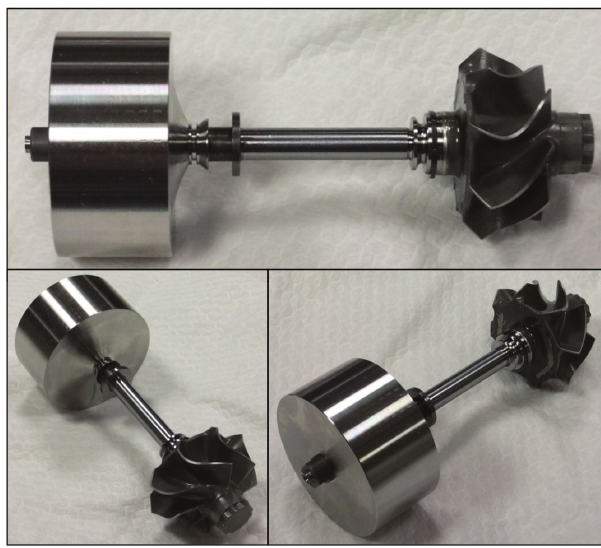
Figure 15: Typical result of an unsteady HIR measurement.